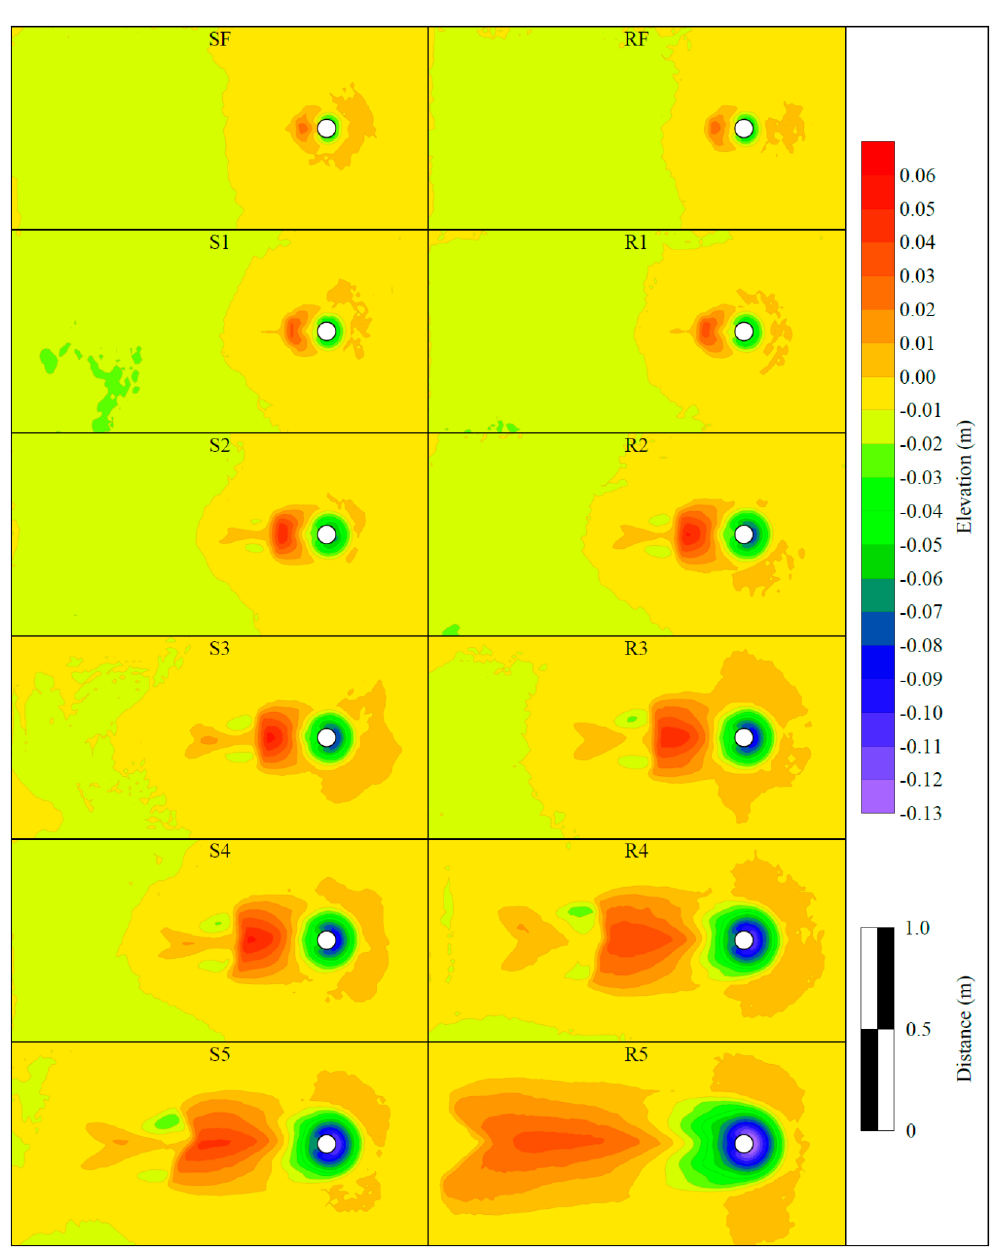
Figure 9. Scour contour plot comparison for the Floating and submerged trials. The difference in scour between the smooth and rough ice covers is minimal for the floating and mildly submerged ice cover tests. As s i increases, the ice cover roughness has a greater influence causing there to be a larger difference in scour between the smooth and rough ice covers. However, for all test conditions, the rough ice cover yielded more